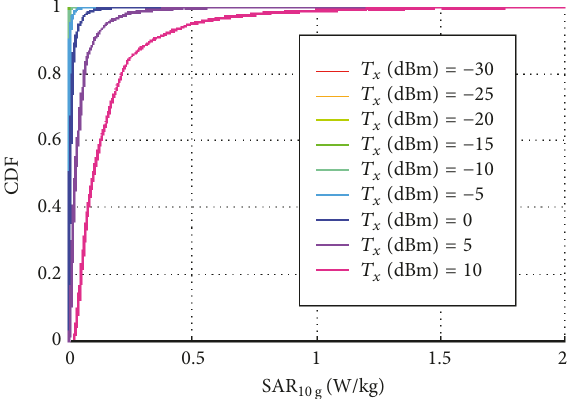
Figure 22: CDFs of SAR peak 10 900 MHz for various values of 𝑇 𝑥 .